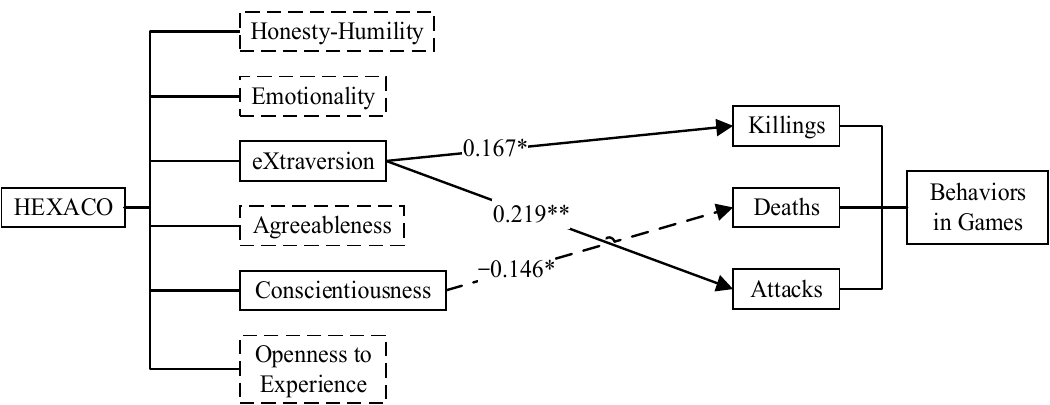
Figure 7. The results of the regression analysis, showing that the personality traits were partly related to in-game behaviors. The significant positive associations were indicated by solid black arrows, the significant negative association were indicated by a dashed black arrow. Honesty/humility, emotionality, agreeableness, and openness to experience, which had no correlation to any in-game behaviors, are indicated by a dotted box. Notes . ** p < 0.01, * p < 0.05.